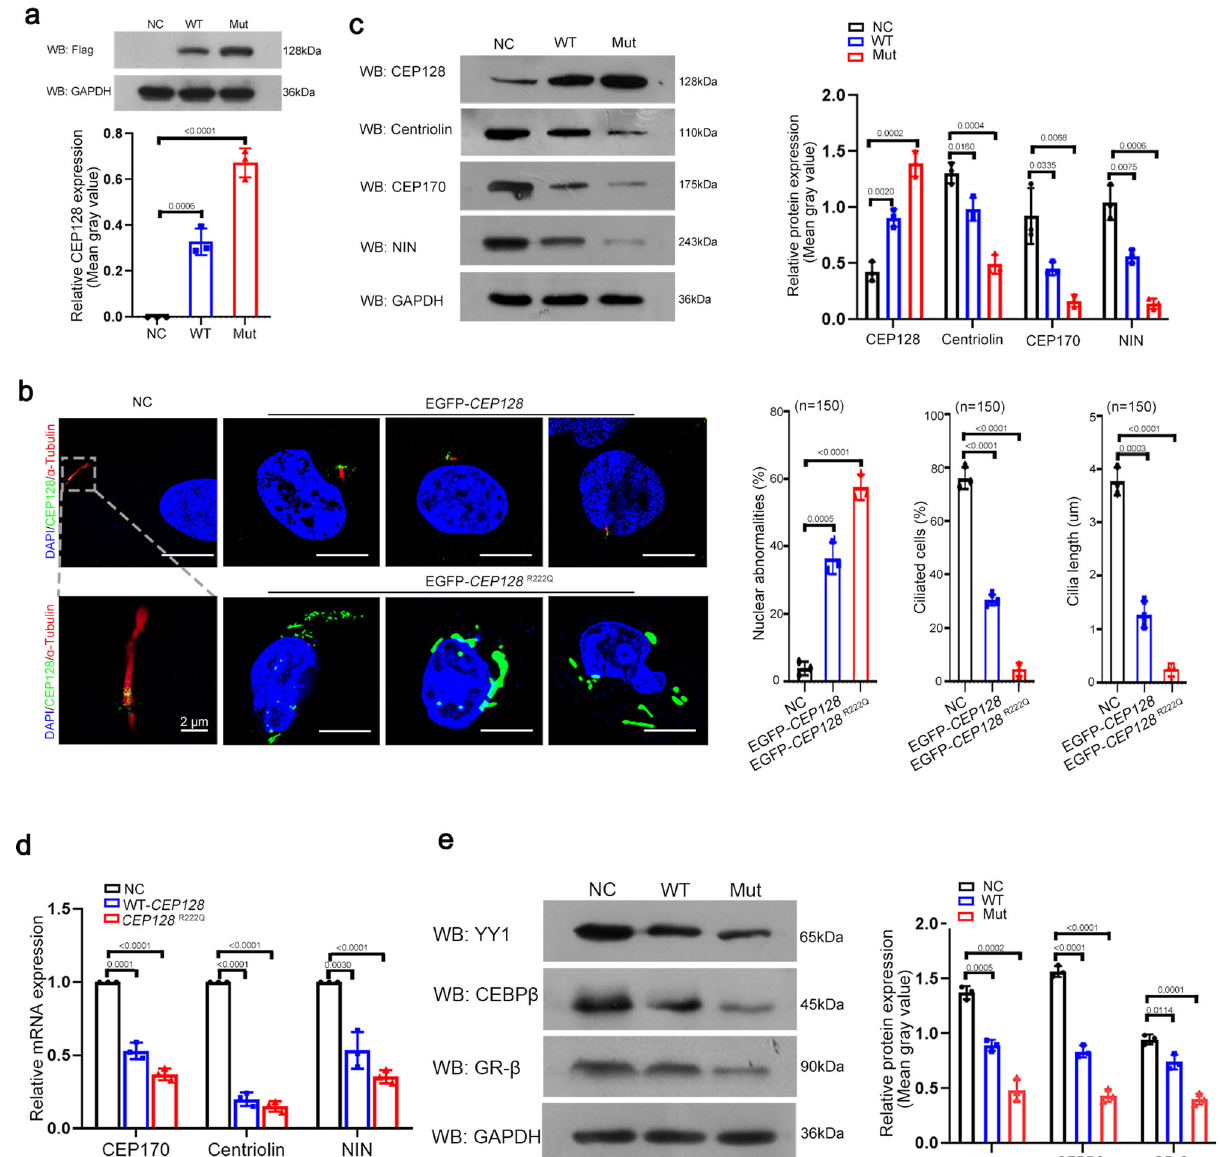
Fig. 3 Functional analysis of the CEP128 R222Q variant in hRPE1 cells. a Western blot analysis showed an increased abundance of CEP128 protein with the CEP128 R222Q variant. NC (negative control), cells transfected with negative control pENTER-Flag plasmid. Three independent experiments were performed. (Two-sided Student ’ s t test; error bars, mean ± SEM). The p values are indicated in the graphs. b Overexpression of CEP128 R222Q compromised ciliary growth and disrupted cellular nuclear morphology. Three independent experiments were performed. Dotted box denoted the basal body and cilia. n the number of cells analyzed. NC (negative control), cells transfected with negative control pENTER-Flag plasmid. (Two-sided Student ’ s t test; error bars, mean ± SEM; green, CEP128; red, Ac-Tubulin; blue, DAPI; scale bars, 10 µ m). The p values are indicated in the graphs. c Decreased levels of NIN, centriolin, and CEP170 were detected in the cells transfected with WT- CEP128 or CEP128 R222Q when compared to the NC by western blot analysis. NC (negative control), cells transfected with negative control pENTER-Flag plasmid. Three independent experiments were performed. (Two-sided Student ’ s t test; error bars, mean ± SEM). The p values are indicated in the graphs. WT- CEP128 and CEP128 R222Q downregulated the mRNA levels for NIN , centriolin , and CEP170 ( d ) by suppressing the expression of their transcription factors ( e ). NC (negative control), cells transfected with negative control pENTER-Flag plasmid. Three independent experiments were performed. (Two-sided Student ’ s t test; error bars, mean ± SEM). The p values are indicated in the graphs. Source data are provided as a Source Data fi